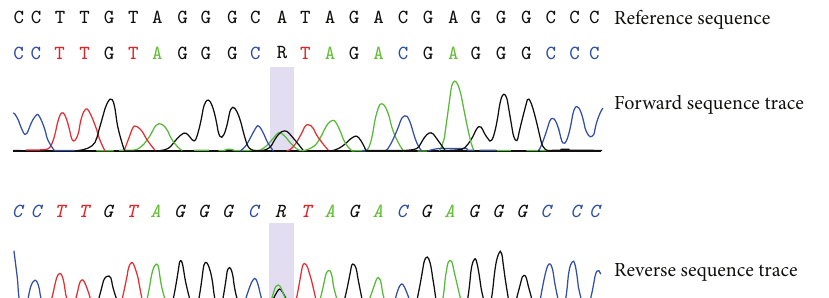
Figure 1: Sequence analysis of proband. Sequence electropherograms show the presence of the c.370A > G, p.Ile124Val (p.I124V), mutation in exon 4 of the GPD1L gene.